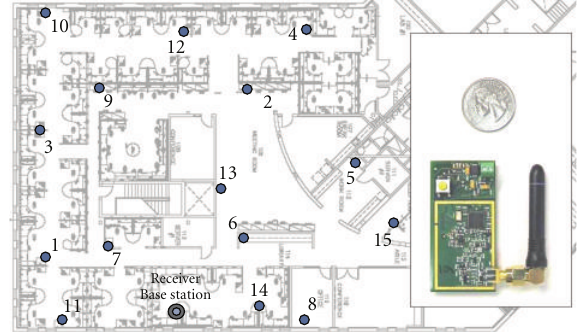
Figure 8: Experiment setup number 1: 15 Bosch CC2420 nodes deployed in an o ffi ce building.